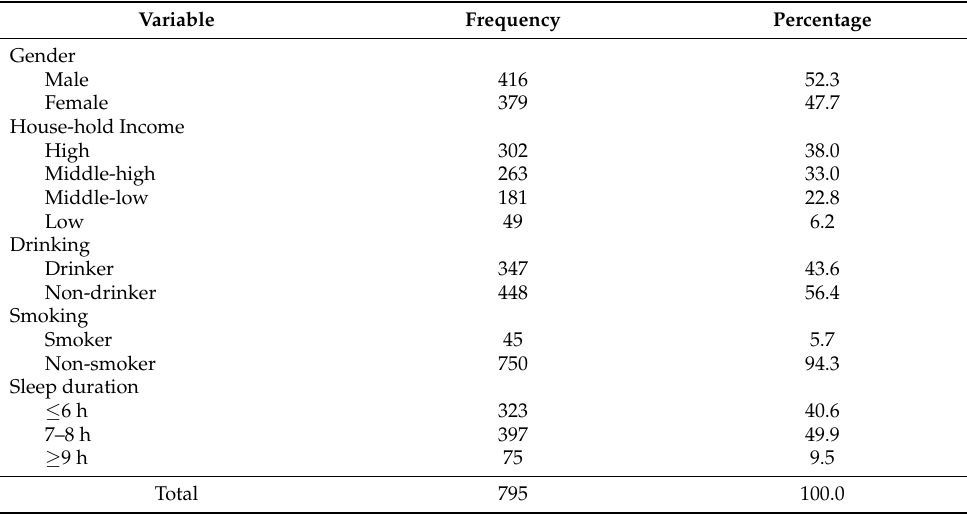
Table 1. General characteristics of